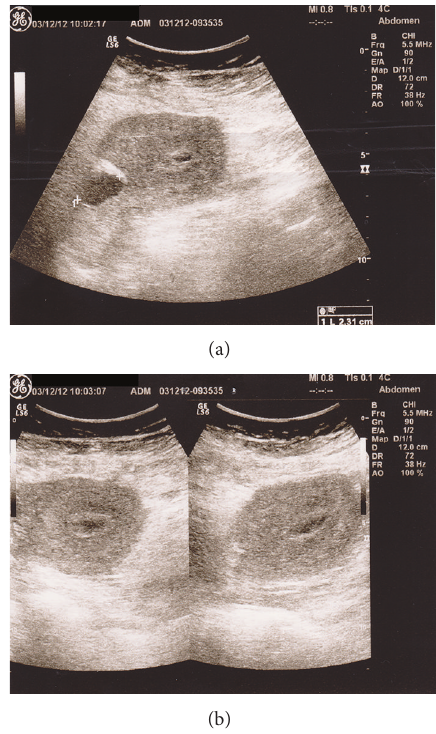
Figure 1: A lesion, 20mm in diameter, consistent with fluid collection, was detected on gray scale sonography.